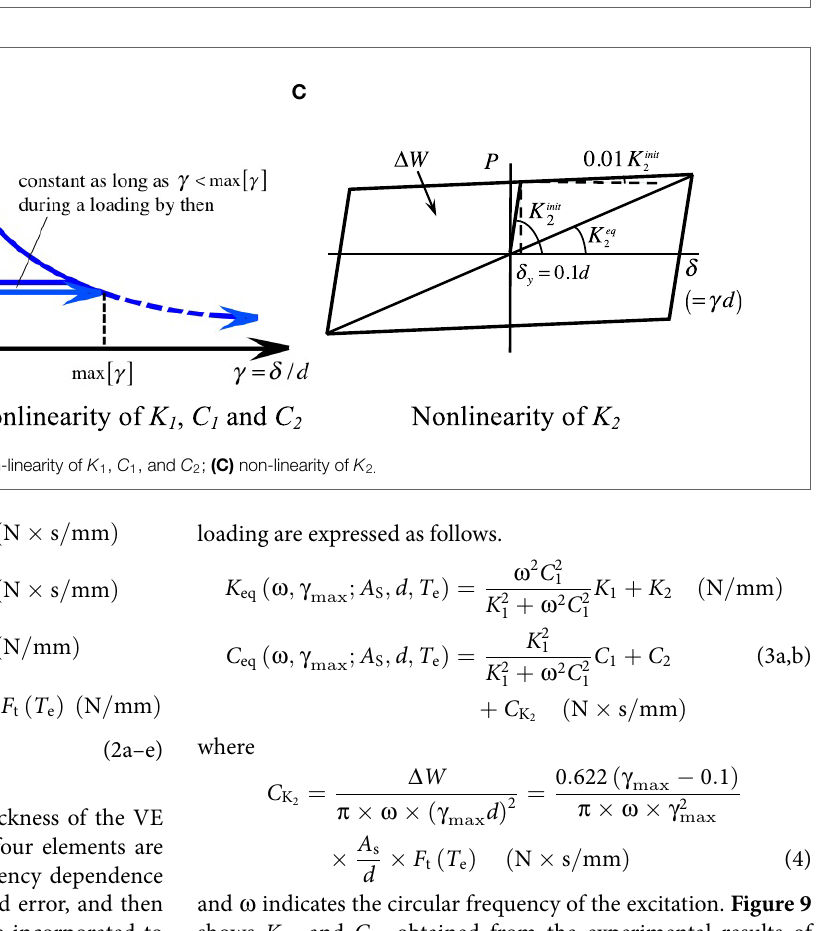
FIGURE 7 | Temperature dependency of the equivalent stiffness and damping coefficient of test VE material . (A) K eq / K eq ( T e = 20°C) and (B) C eq / C eq ( T e = 20°C).